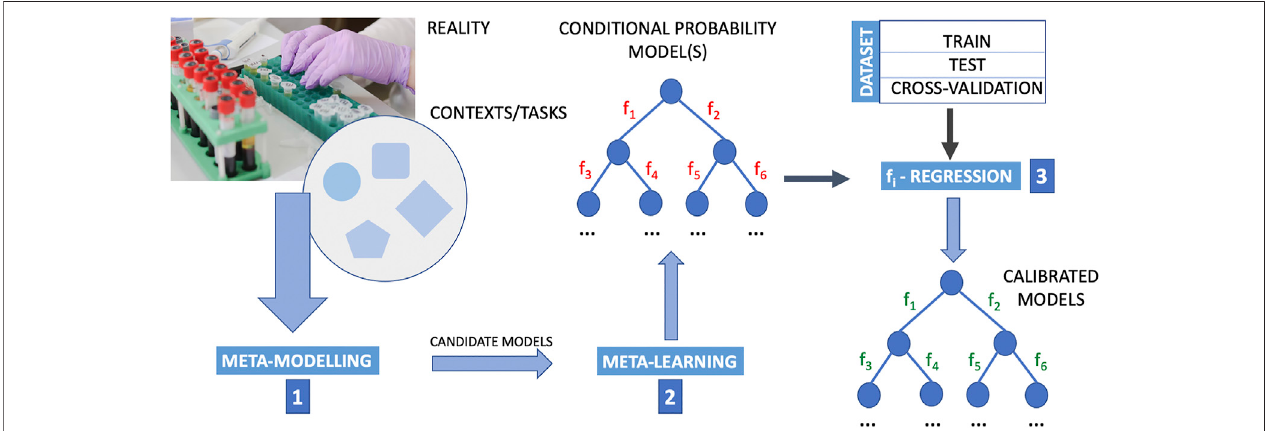
FIGURE 1 | Outline of a computational procedure using upstream meta-modelling for the inference of causal structures. Meta-learning into a composite upside- down framework that includes the following phases in the following order. Step 1: meta-modelling fi rst provide candidate models; step 2: meta-learning is designed to learn from data the conditional probability structure of these models where the structure and parameters of mathematical relations de fi ning the interaction between nodes(i.e.thefunctions f i , i (cid:1) 1,2, ... , M with M thenumberofarcintheprobabilitygraph)arethendeterminedbyregressionmethods(step3).Byemployingmeta- modelling upstream to meta-learning, and meta-learning it-self in place of a direct application of machine-learning, this pipeline extends a typical machine learning approachthatgenerallyposestheproblemofstructuralcausaldiscovery asaproblemoflearningthefunctions f i .Inthispipeline,thedeterminationofoptimal f i functions is posed as a regression problem once meta-modelling and meta-learning has identi fi ed wiring diagrams. The data are essential to the learning and regression procedure. The data are typically divided into train set, test set and cross-validation set. Cross-validation is a resampling procedure used to assess machine learning modelsonalimiteddatasample,andforthesakeofsimplicityinthis fi gureisreportedasasubsetofthedataset.However,theprocedurehasasingleparametercalled K that refers to the number of groups that a given data sample is to be split into (for this reason for “ cross-validation ” it is usually meant K-fold cross-validation.). In K-fold crossvalidationwehavemultiple(K)train-testsetsinsteadof1,sothatwetrainandtestthemodelK-times.Thepurposeofdoingthisisthatinasingletrain-testsplit,the testpartofthedatathatwechosemightbereallyeasytopredictandthemodelwillperformextremelywellonitbutnotexactlysofortheactualtestsets.Theimageofthe laboratory in this fi gure is part of the Pixabay free online pictures (https://pixabay.com/it/).